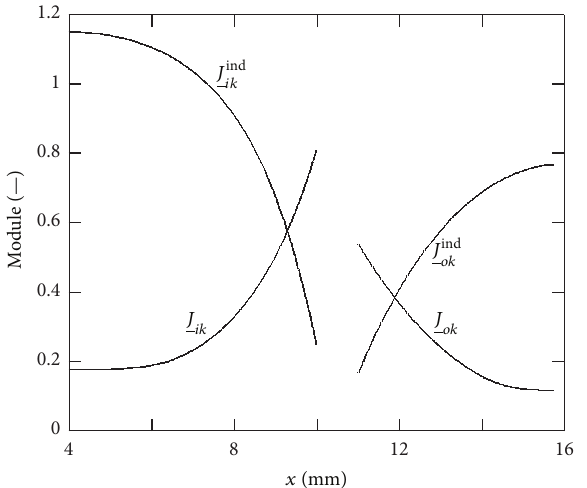
Figure2:Dependenceofphasormoduleofresultantcurrentdensity 𝐽 and of phasor module of induced current density 𝐽 ind 𝑐𝑘 from axis of conductors in Example 1 for 𝑓 = 10 3 Hz, 𝑛 = 1000 . The module values have been normalized with respect to 10 7 A ⋅ m −2 .